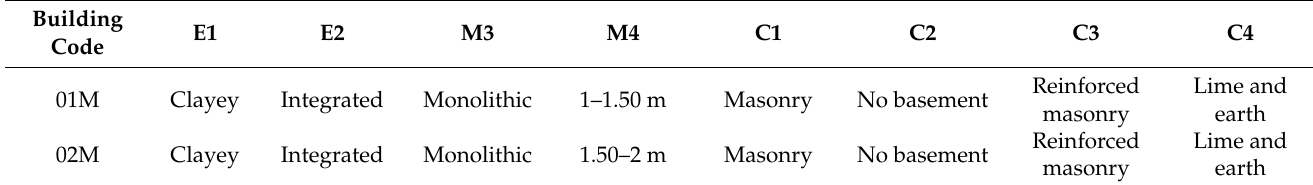
Table 6. Monumental building characteristics.